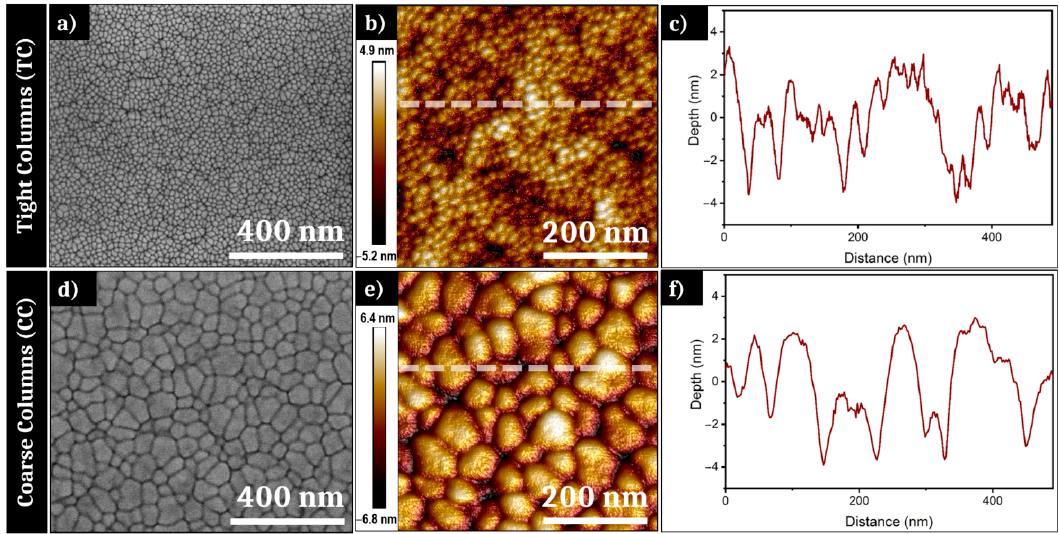
Figure 2. ( a ) Scanning electron microscope (SEM) picture and ( b ) atomic force microscope (AFM) 3D-projection of the surface of the Tight Columns (TC) sample; ( c ) height profile of the white line in ( b ); ( d ) SEM picture and ( e ) AFM 3D-projection of the surface of the Coarse Columns (CC) sample; ( f ) height profile of the white line in ( e ).